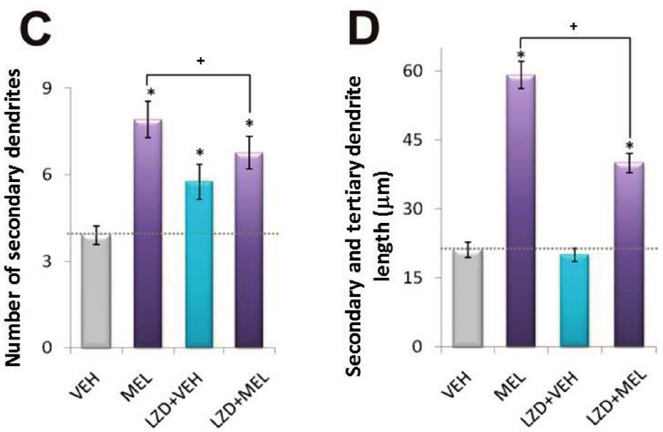
Figure 7. Morphometric analysis of dendrite formation elicited with Melatonin in presence of Luzindole. Hippocampal slices were incubated for 6 h with either the vehicle (VEH), 100 nM melatonin (MEL), or were pre-incubated with luzindole (LZD) for 15 min followed by 6 h incubation with the vehicle (LZD + VEH) or 100 nM melatonin (LZD + MEL). After the incubation time, slices were cut into 50 µM sections and immunostained for the specific marker of dendrites MAP2. Slices were analyzed by the modified Sholl